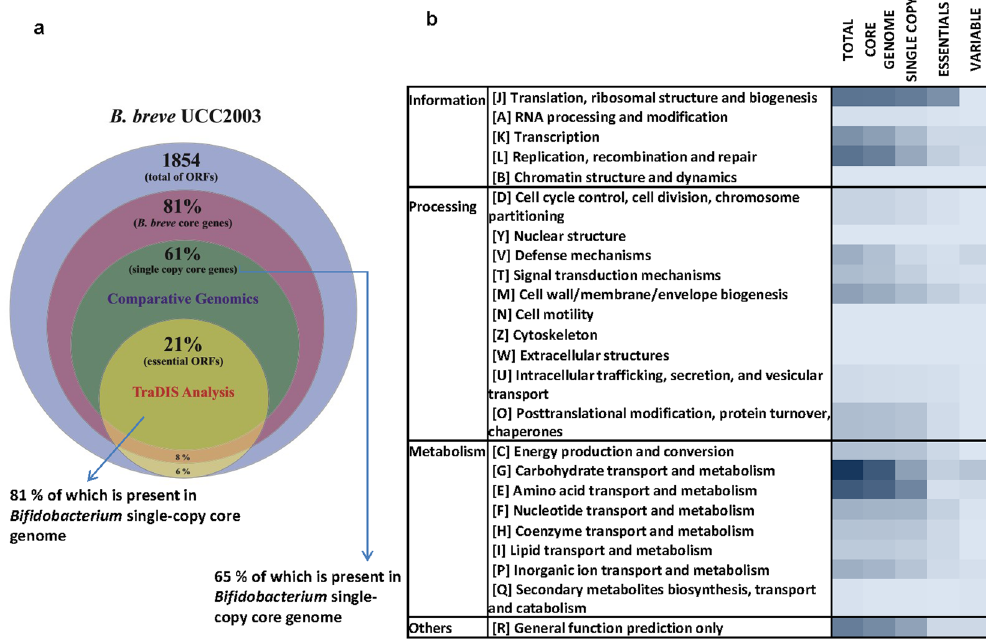
Figure 3. ( a ) Venn Diagram representing the overlap between the essential genes determined by TraDIS analysis for B. breve UCC2003, the Bifidobacterium and B. breve core genomes, as well as B. breve core genes present in single copy. ( b ) Heatmap representing in colour gradient the frequency of COG categories across all the different type of gene families resulting from comparative analysis of B. breve UCC2003 total gene content and TraDIS predicted essential genes, against the available Bifidobacterium